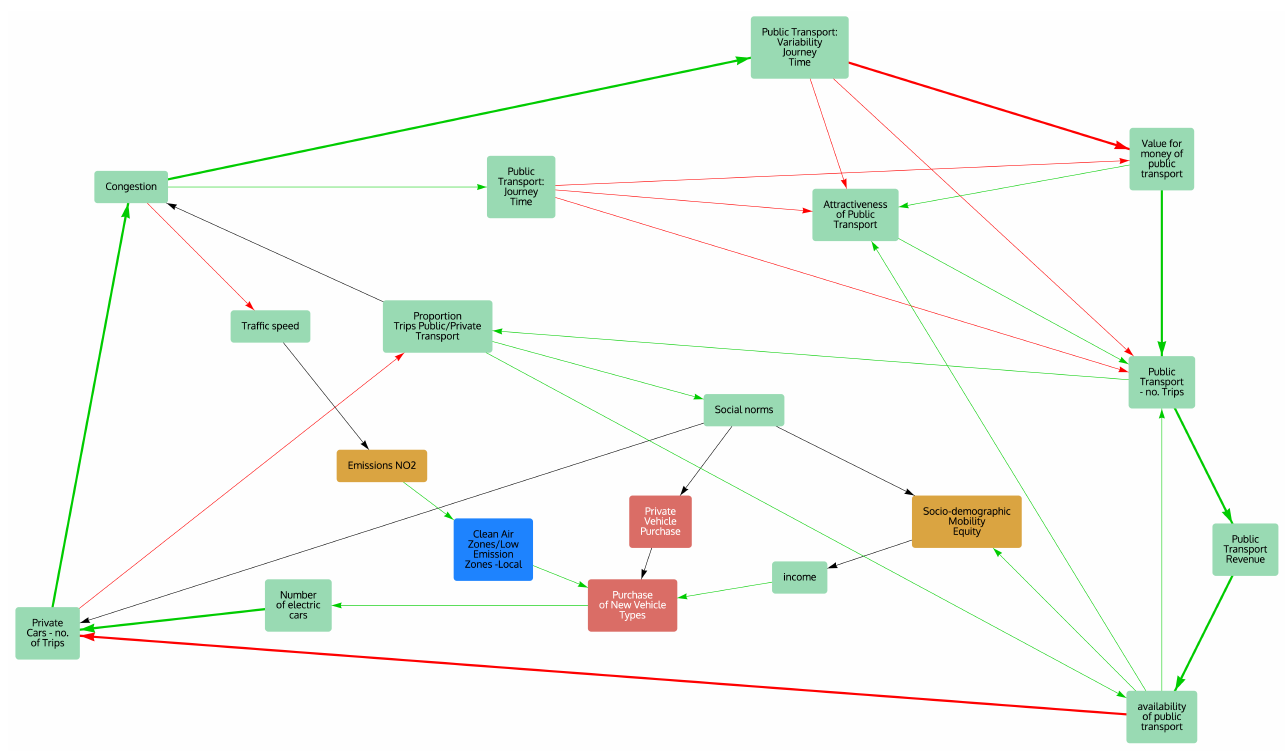
Figure 5. Public transport feedback loops extracted from the